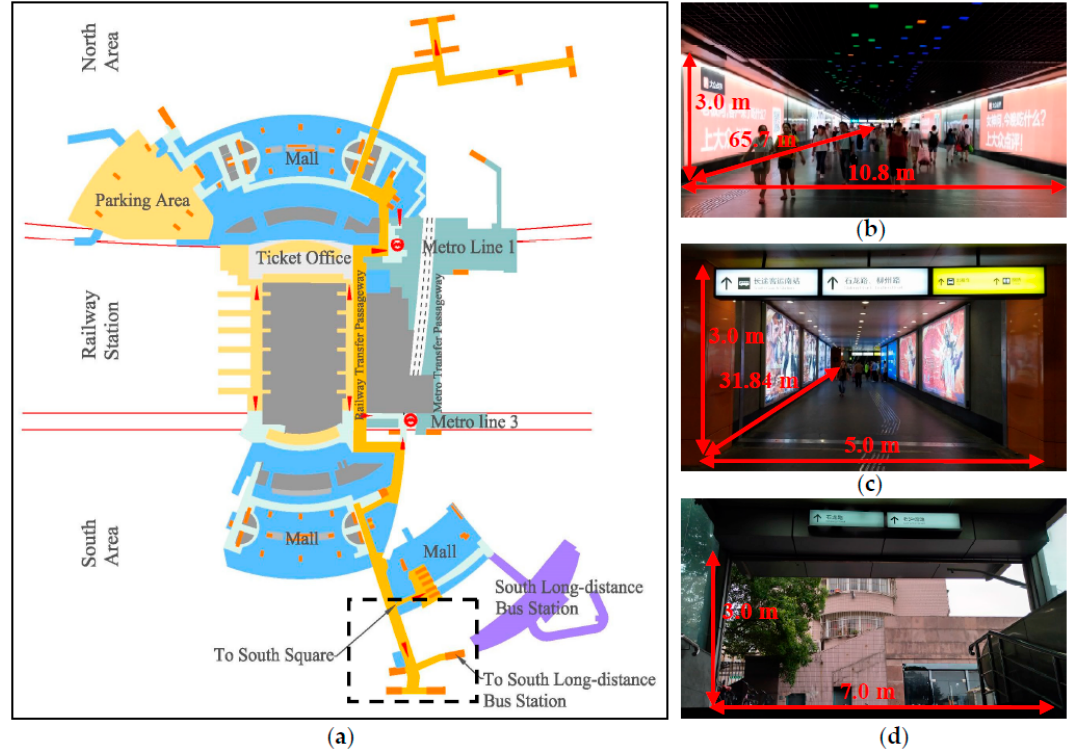
Figure 1. Experimental site in the Shanghai South Railway Station. ( a ) The Shanghai South Railway Station sketch map of the basement floor; ( b ) A view of main segment of the selected passageway; ( c ) A view of the branch of the selected passageway; ( d ) A view of the entrance of the selected passageway.